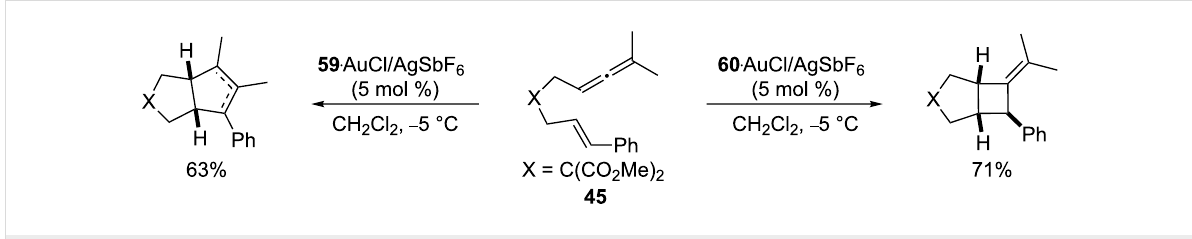
Scheme 31: (3 + 2) versus (2 + 2) Cycloadditions of allenenes [106].